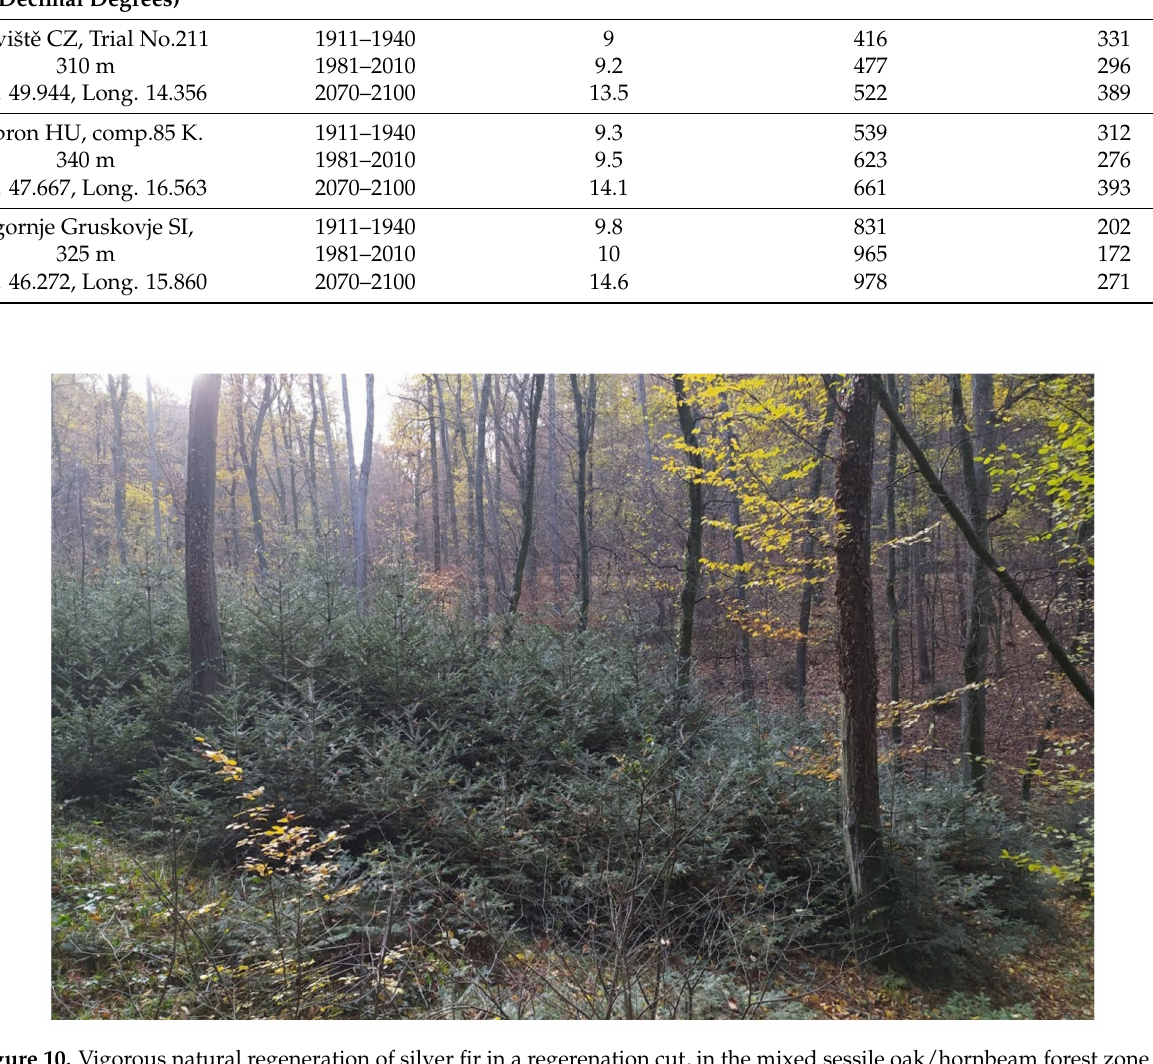
Figure 10. Vigorous natural regeneration of silver fir in a regerenation cut, in the mixed sessile oak/hornbeam forest zone in Sopron, Hungary, at the xeric limits of artificially re-introduced silver fir (elevation 340 m, current climatic moisture deficit: 276 mm, further details in the text and Table 6; photo: P. Bal á